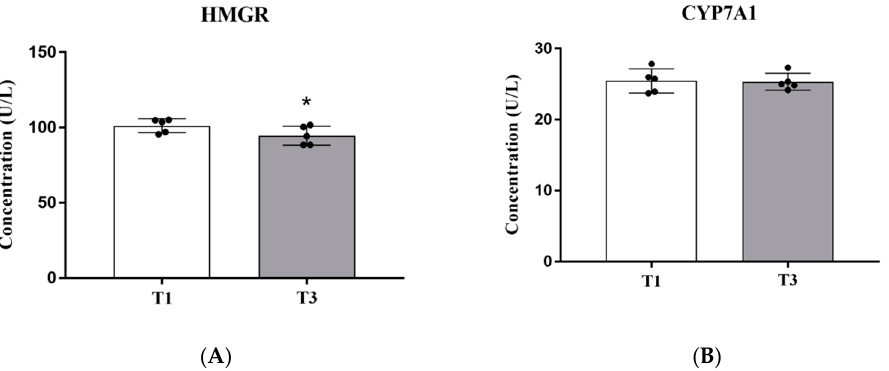
Figure 5. Effects of AGE supplementation on the enzyme activities of HMGR ( A ) and CYP7A1 ( B ) in the liver of broilers. * p < 0.05. T1: the broilers were fed a basal diet; T3: the broilers were fed a basal diet supplemented with AGE at 0.4%. HMGR,3-hydroxy-3-methylglutaryl-CoA reductase; CYP7A1, cholesterol 7 α -hydroxylase.